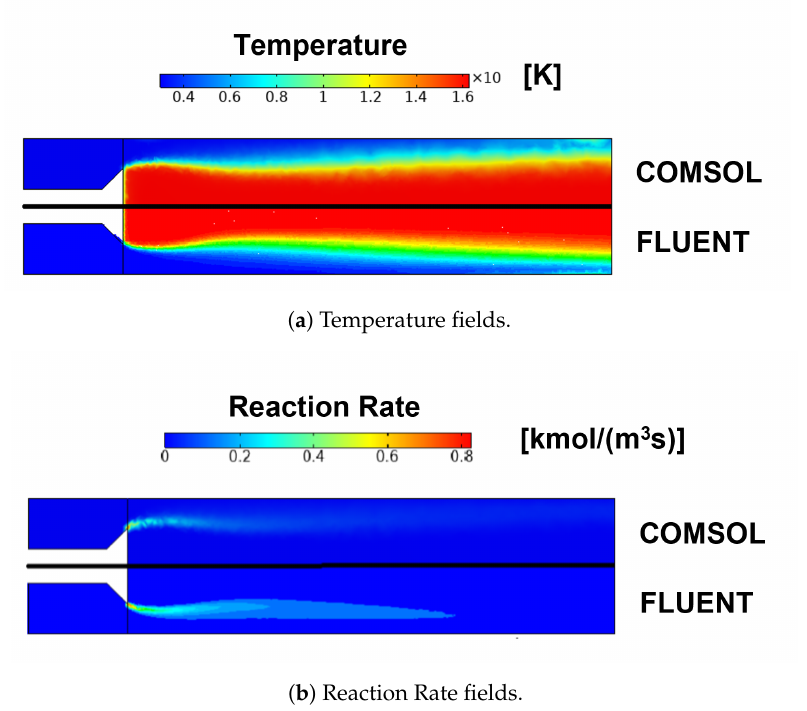
Figure 22. Comparison between the CFD solutions and the same fields interpolated on the COMSOL mesh for the burner fueled with CH 4 –air mixture (Temperature field ( a ) and Reaction Rate field ( b